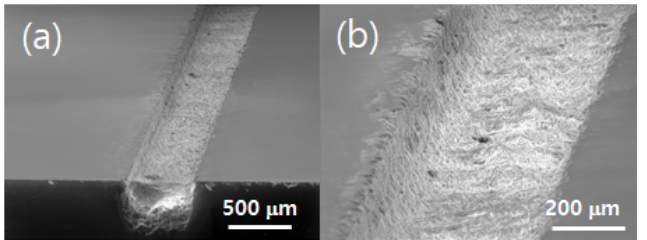
Figure 13. SEM image of the groove produced by multiple laser scans (number of scans per scan track: 5 and number of scan tracks: 17) using method 3 (laser power: 2.28 W, scan speed: 25 mm/s, pulse repetition rate: 30 kHz, and scan spacing: 30 μm). ( a ) Low magnification and ( b ) high magnification.